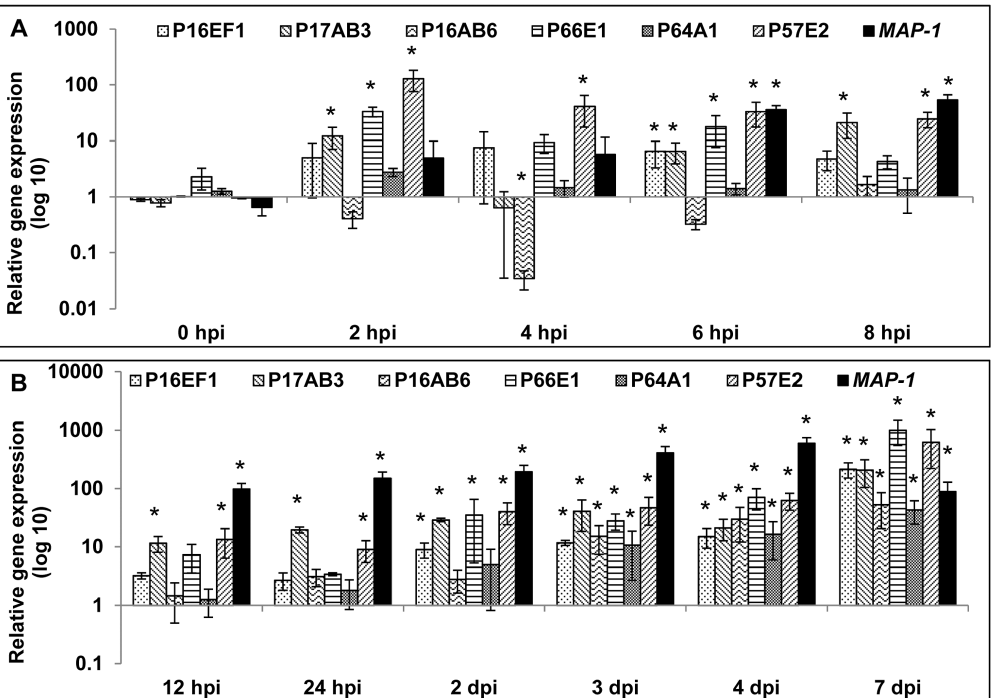
Figure 6. Gene expression analysis of 6 selected TDFs during pre-penetration, penetration and post-penetration stages of the A. thaliana - M.incognita interaction. A, Gene expression analysis by qRT-PCR of 6 transcript-derived fragments (TDFs) and MAP-1 during the pre- penetration stage. B, Gene expression analysis by qRT-PCR of 6 TDFs and MAP-1 during the penetration and the post-penetration stages. Error bars indicate + / 2 SEM (3 biological repeats). Statistical significance (ANOVA) of pair-wise comparisons between nematodes in close contact with roots (from 2 hpi to 8 hpi), nematodes penetrating or inside the roots (from 12 hpi to 7 dpi) and non-root exposed-nematodes (0 hpi) are indicated by asterisks (P ,